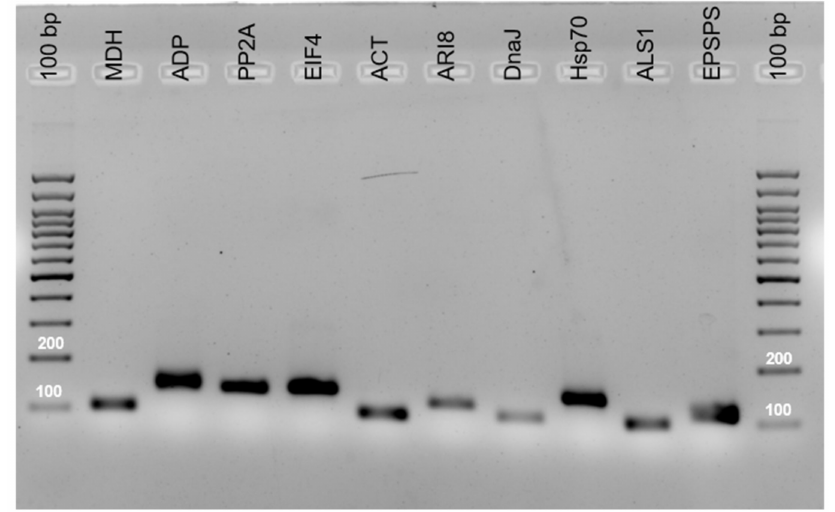
Figure 1. Amplification products of the nine candidate reference